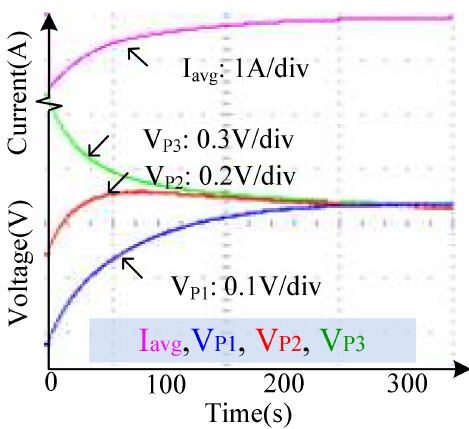
Figure 8. The balancing waveforms and average current waveform from the experiment in the laboratory. (CH1: I avg is average discharge current; CH2: V P 1 is voltage of source package1; CH3: V P 2 is voltage of source package2; CH4: V P 3 is voltage of source package3).